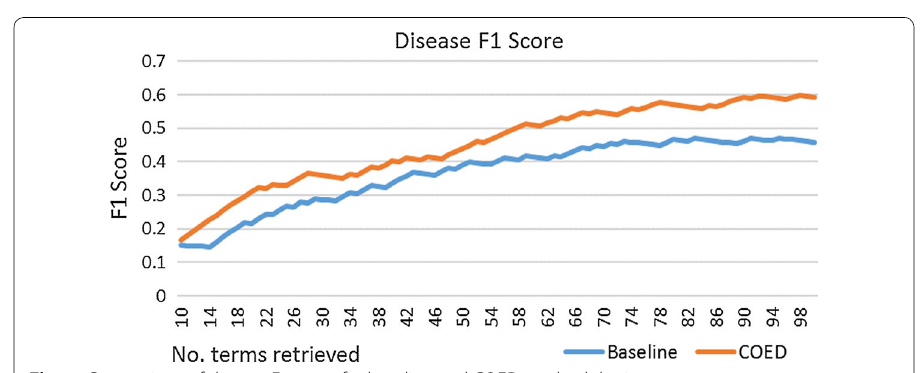
Fig. 7 Comparison of disease F1 score for baseline and COED